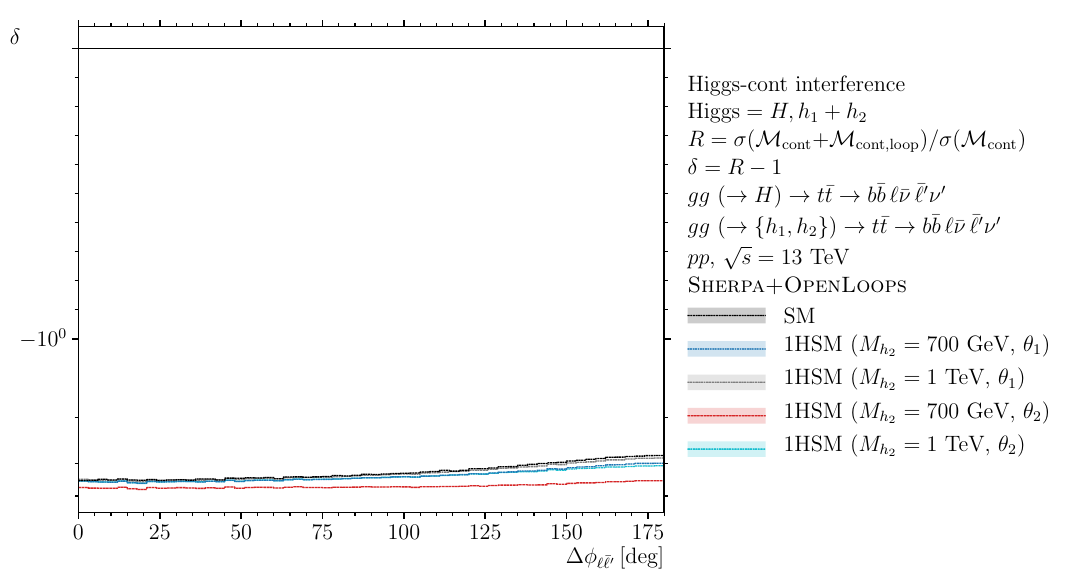
Figure 25 . ∆ φ distributions of the relative deviation δ = R (cid:31) ¯ (cid:31) (cid:31) background without and with the virtual corrections in the SM and 1HSM ( M h ) for gg ( H, h 1 , h 2 ) t ¯ t b ¯ b (cid:20) ¯ ν ¯ (cid:20) (cid:31) ν (cid:31) in pp collisions at √ s = 13 TeV. Other details as θ 1 , θ 2 } → { } → → { in figure